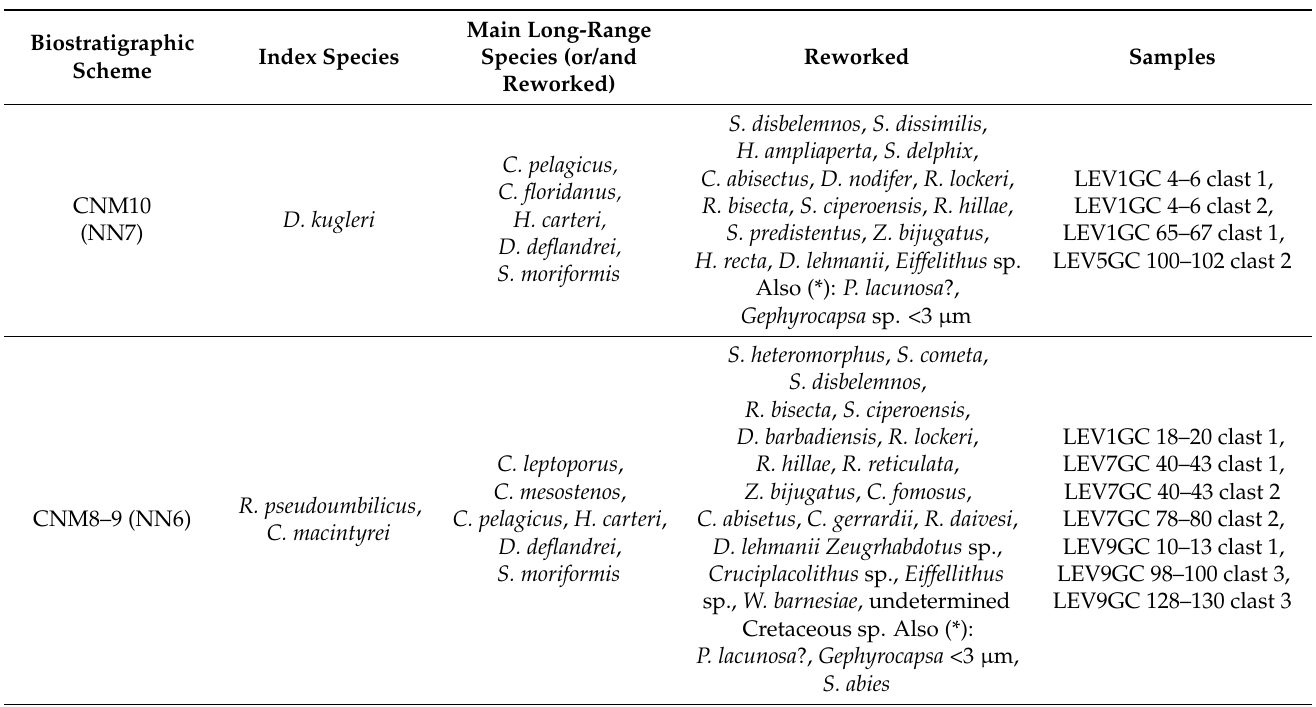
Table 1. Biozones determined by the nannofossil study of the clast samples. The index species suggest the stratigraphic range of the samples, while the reworked species can provide valuable information about the basin’s evolution. The correlation with Martini [32] biozones appears in parentheses. (*) Miocene–Pliocene species associated with potential contamination caused by the upward migration of mud